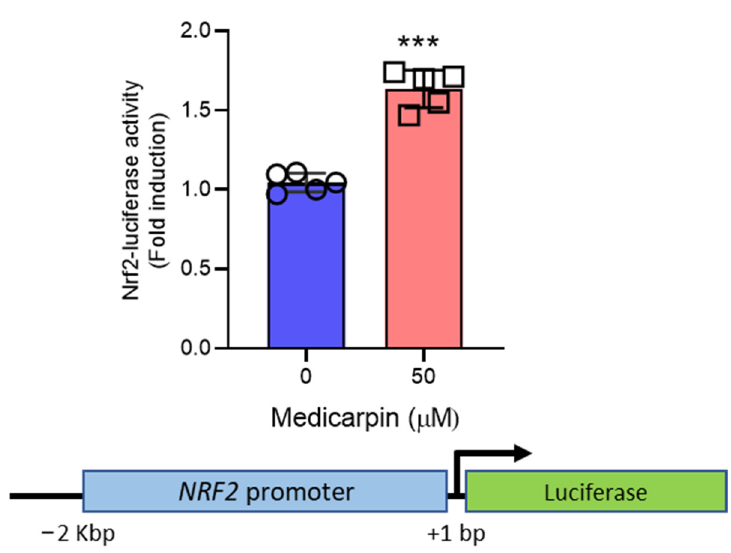
Figure 4. Medicarpin induces the NRF2 transcriptional level in Hela cells. Cells were treated with 50 µM of medicarpin for 6 h in the condition of transfection with an NRF2-promoter luciferase construct. NRF2-luciferase activity was measured using a Dual-Luciferase Reporter Assay kit (Promega) according to the manufacturer’s instructions. Experiments were performed in quintuplicate. *** p < 0.0001.